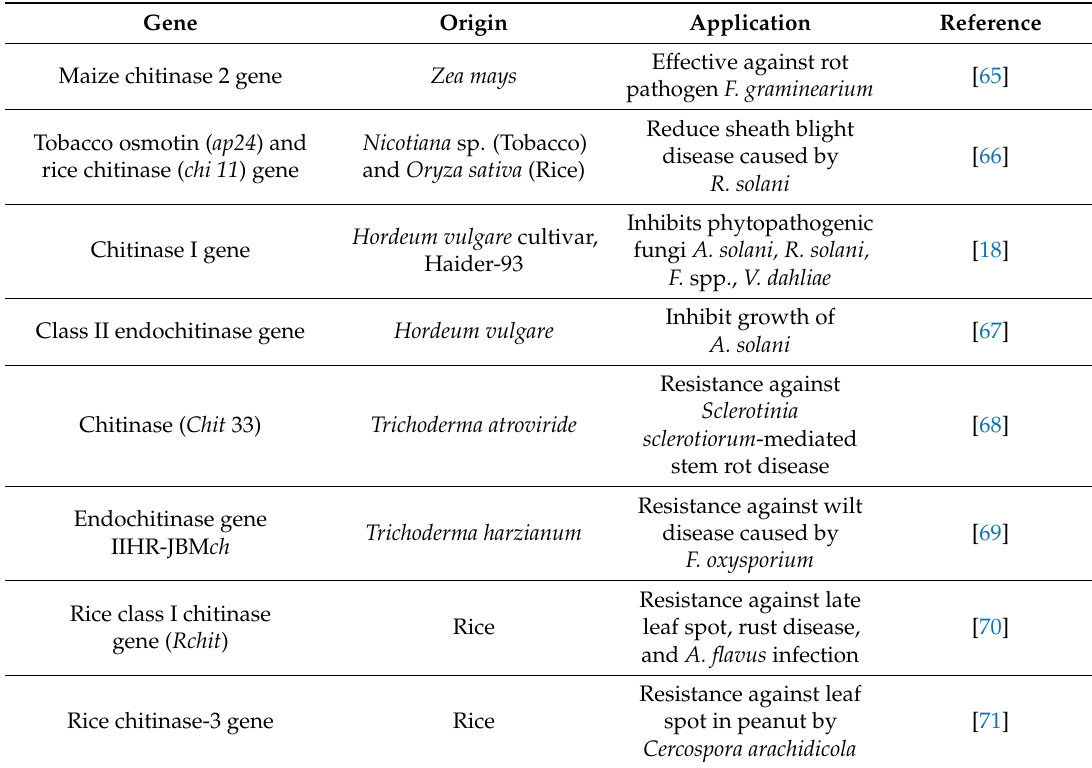
Table 1. Chitinase gene expression and